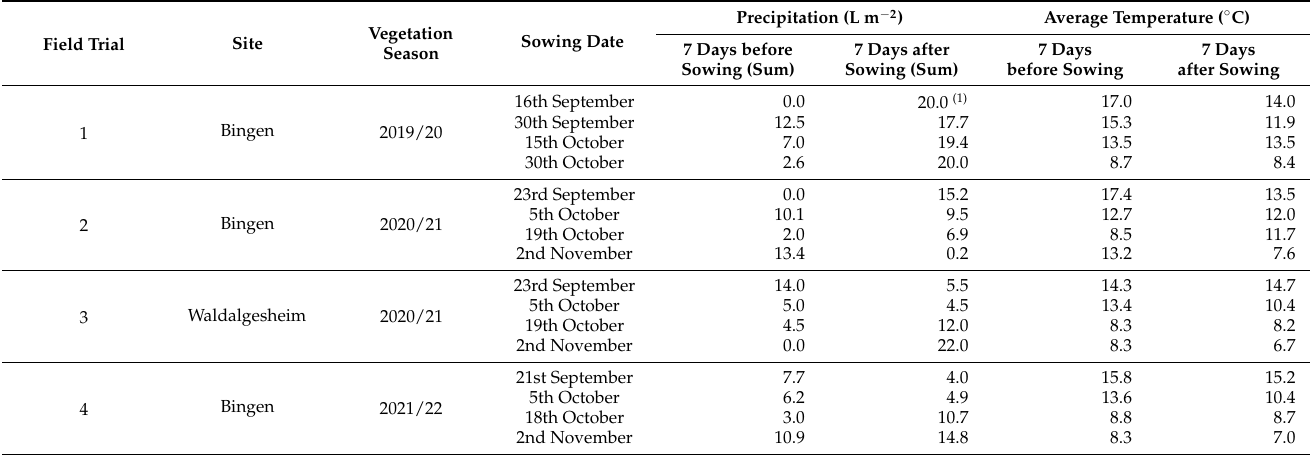
Table 5. Sowing date of winter barley and winter wheat with corresponding precipitation (L m − 2 ) as well as average temperature ( ◦ C) 7 days before and 7 days after